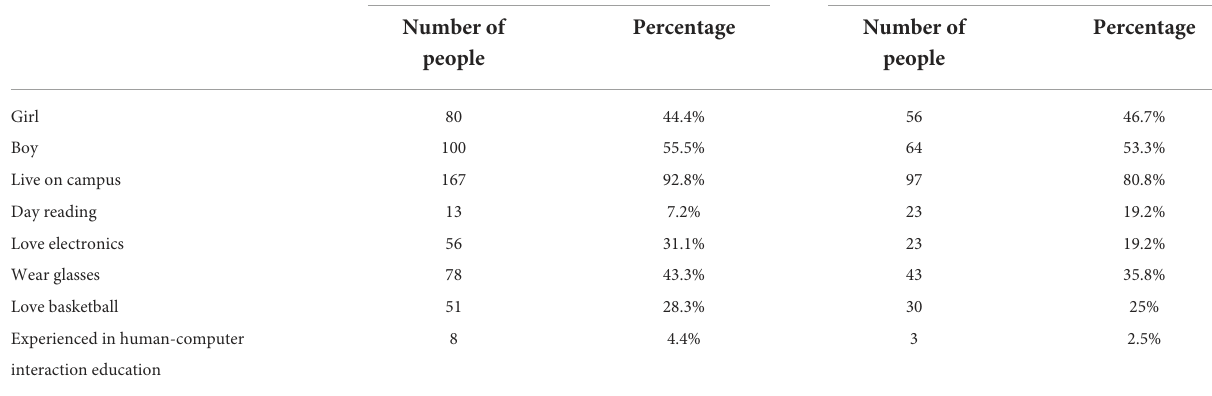
TABLE 3 Sample data table in basketball